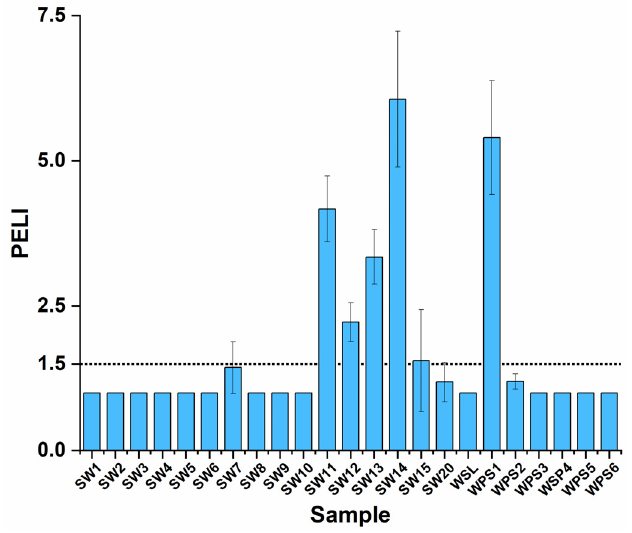
Figure 5. PELI values of the samples with CHK1 as a biomarker. SW1–SW15 and SW20 are the surface water samples. WSL is the sample collected from a water source reservoir, and WPS1–WPS6 are the samples collected from possible pollution sources.